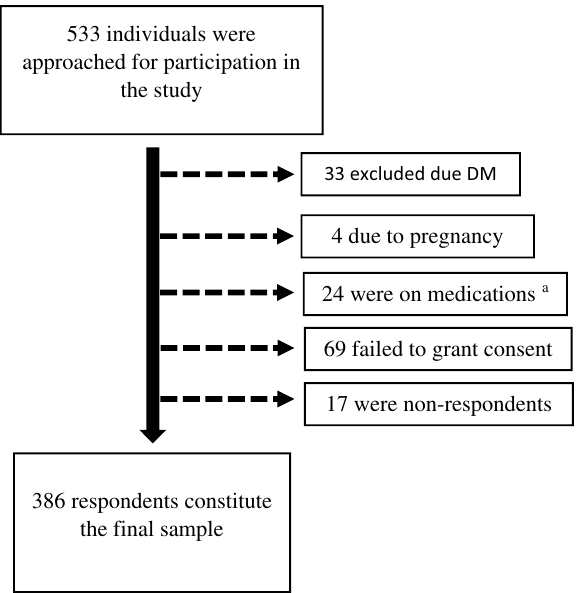
Figure 1. Flow chart for study participant recruitment. a Steroid, β-adrenergic blockers, thiazide diuretics, anti-IV medication, and/or